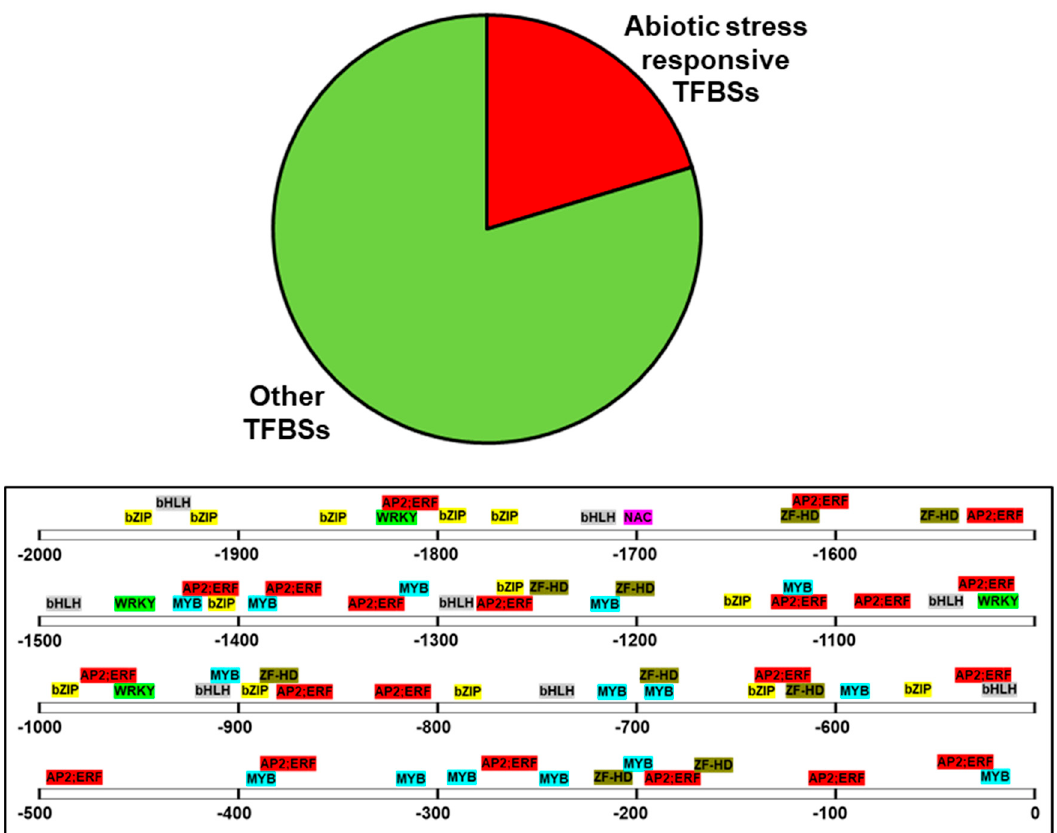
Figure 3. Sequence analysis of the putative promoter region of PdPIP1;2 . The figure shows the distribution of abiotic stress-responsive transcription factors binding sites (TFBSs), which represent 20% of the total TFBSs predicted within the 2000 bp of the putative promotor.